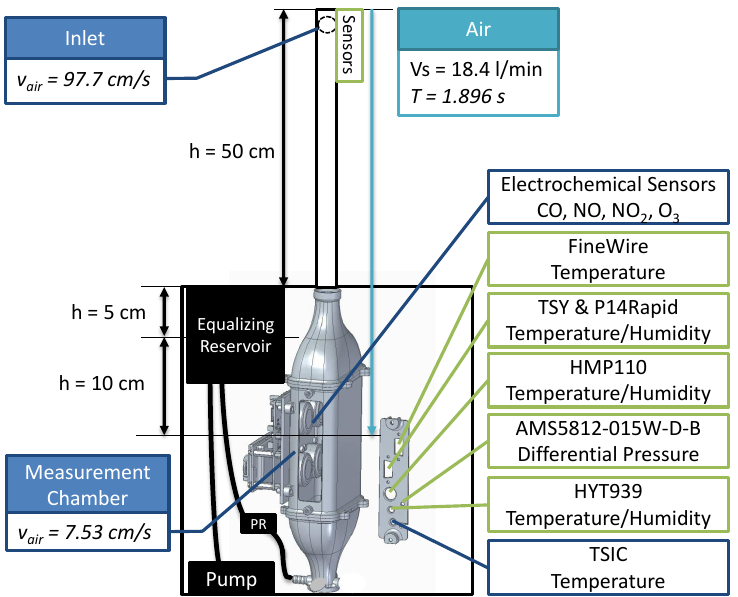
Figure 4. Implementation of the measurement chamber including the air flow system within the Measurement